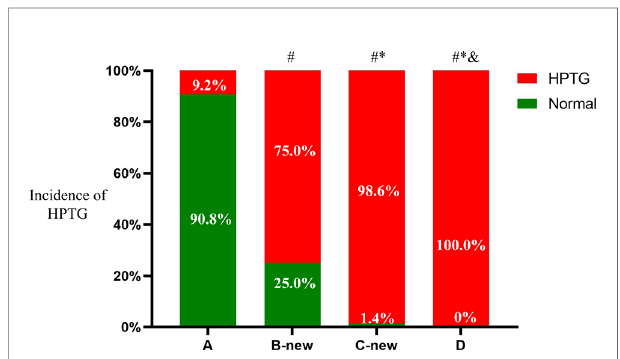
FIGURE 3 | Trend of TG at different time points during the OFTT. Blood was taken at baseline and every 2 hours after the OFTT. The changing trend of triglycerides concentrations were analyzed to determine differences of lipids metabolism among groups with different fasting triglycerides concentrations. All data are expressed as mean.